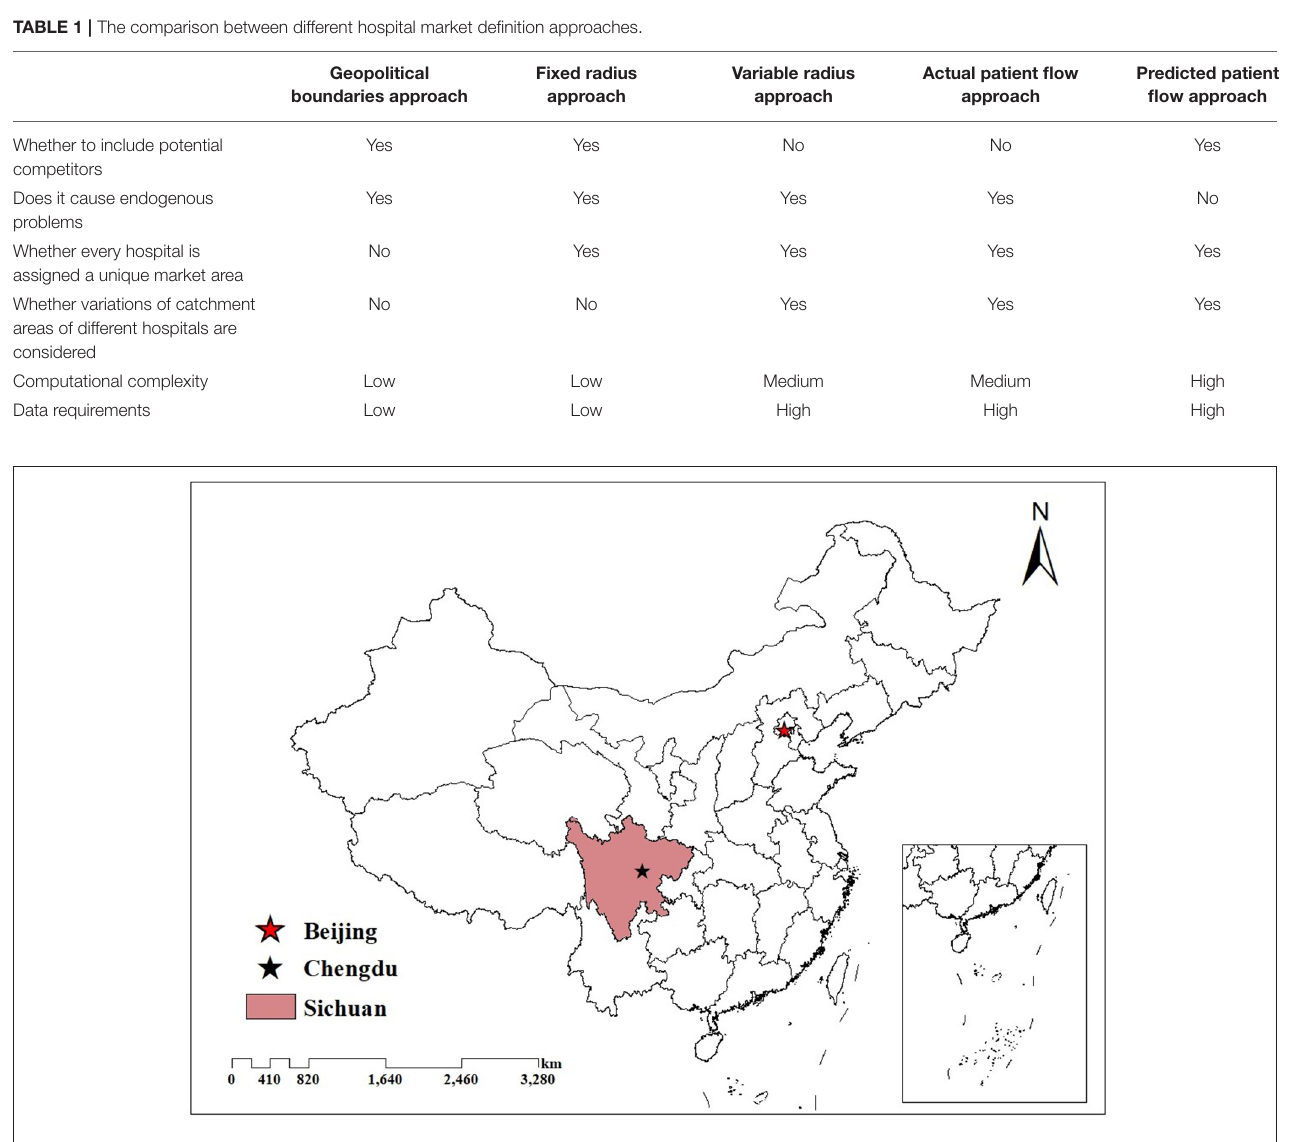
FIGURE 1 | Sichuan’s location in